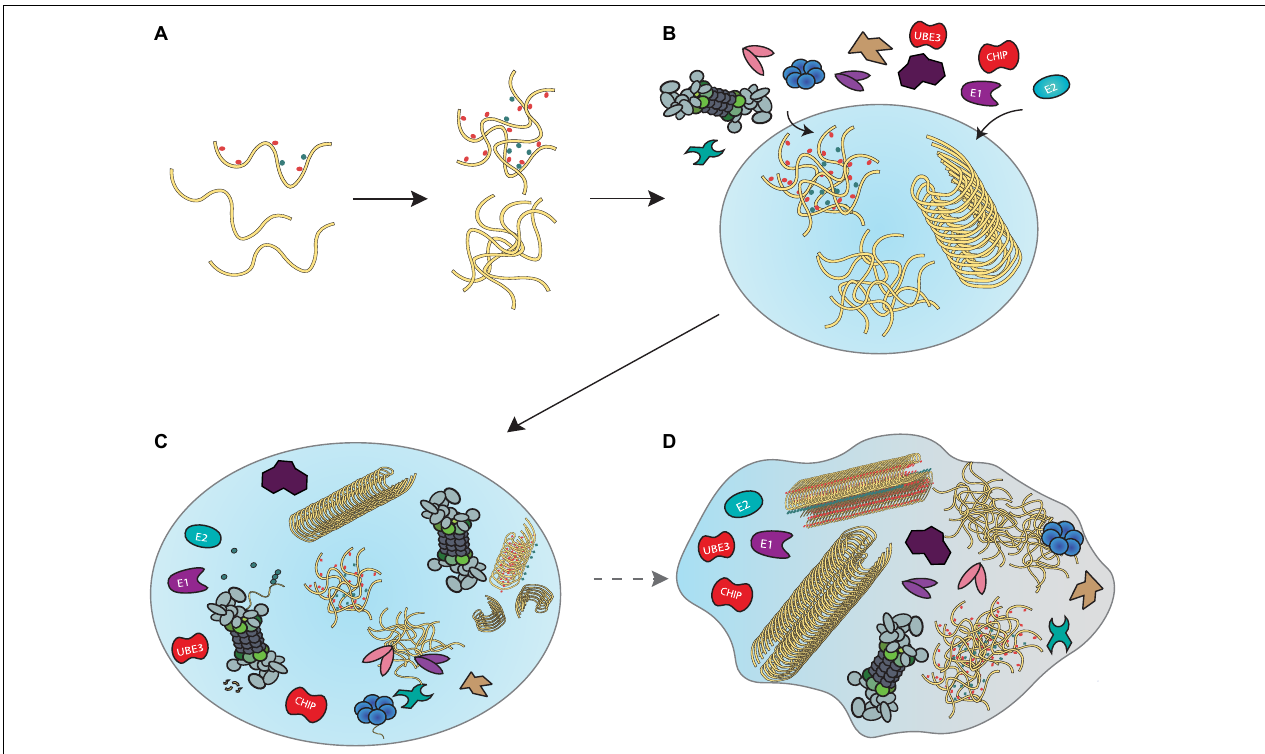
FIGURE 4 | A model for disaggregation and degradation reactions mediated by liquid droplets. (A) Proteins that misfold inside a cell begin to accumulate and form liquid droplets through LLPS principles. (B) Recruitment of the ubiquitin-proteasome system, VCP and HSP70 disaggregation machineries and co-proteins that support their functions enable locally concentrated enzymatic activities in liquid droplets to prevent further accumulation of misfolded proteins. (C) Formation of such “transient aggregate-associated droplets” (TAADs) enable concerted actions of fibril disassembly, ubiquitination and unfolding of aggregates and substrate degradation to occur within a dedicated environment. (D) Prolonged stalling of the various enzymes in the TAADs through disassembly- and degradation-resistant aggregation mechanisms may be associated with gradual phase shift towards a more gel-like state that could be relevant to